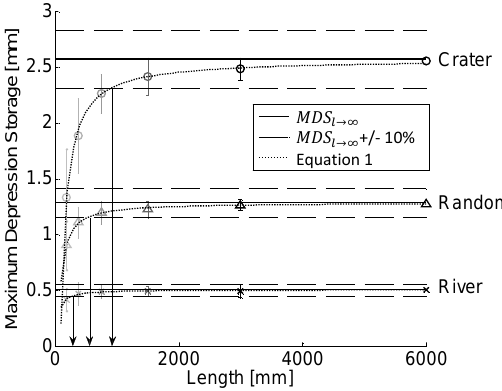
Figure 12: Synthetic Fields – Effect of plot length on the maximum depression storage for the 2 Fig. 12. Synthetic fields – effect of plot length on the maximum “River”, “Random” and “Crater” type microtopographies. Vertical bars = standard 3 depression storage for the river, random and crater type microto- deviations. The arrows indicate the ‘representative length’. All the plots are 6 m wide. 4 pographies. Vertical bars=standard deviations. The arrows indicate the representative length. All the plots are 6m